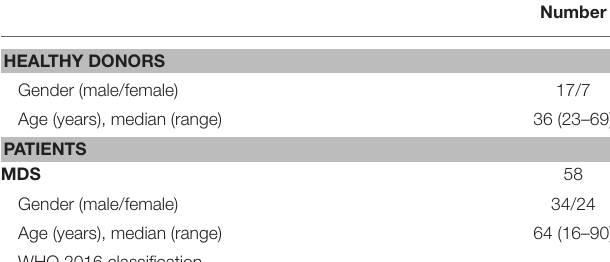
TABLE 1 | Characteristics of healthy donors and patients.